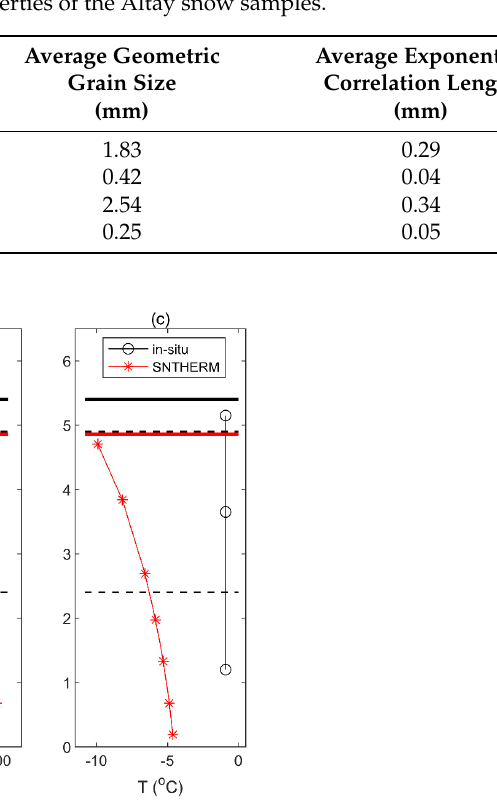
Table 1. Statistics for the multiple-layer snow properties of the Altay snow samples.